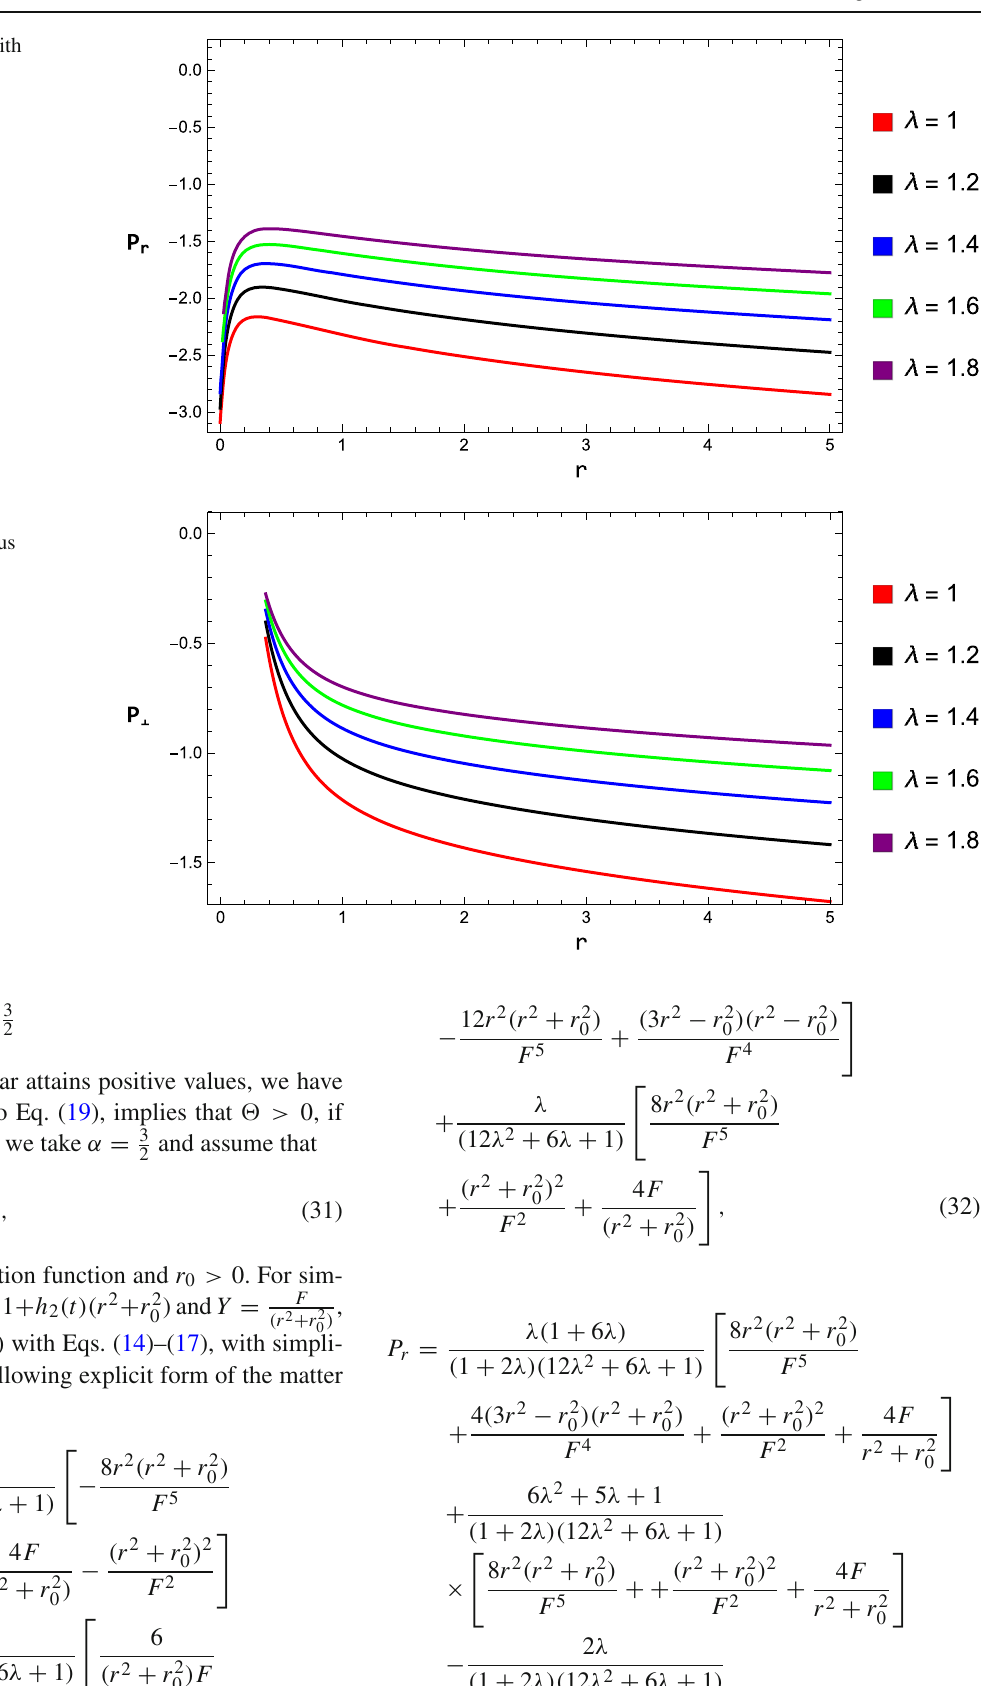
Fig. 3 The variation of P ⊥ with respect to r for the various values of λ and h 1 ( t ) =